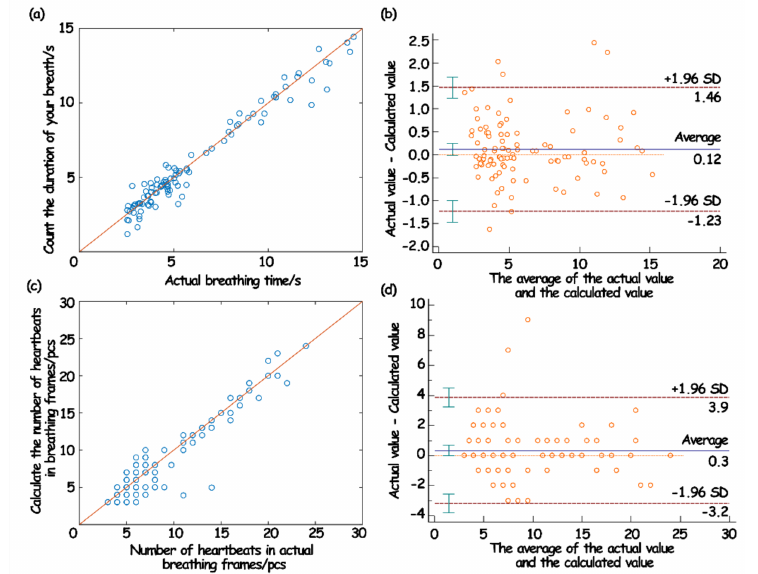
Figure 16. The correlation of respiratory wave duration ( a ) and Bland–Altman analysis diagram ( b ); the correlation of heartbeat number ( c ) and Bland–Altman analysis chart in breathing frame ( d